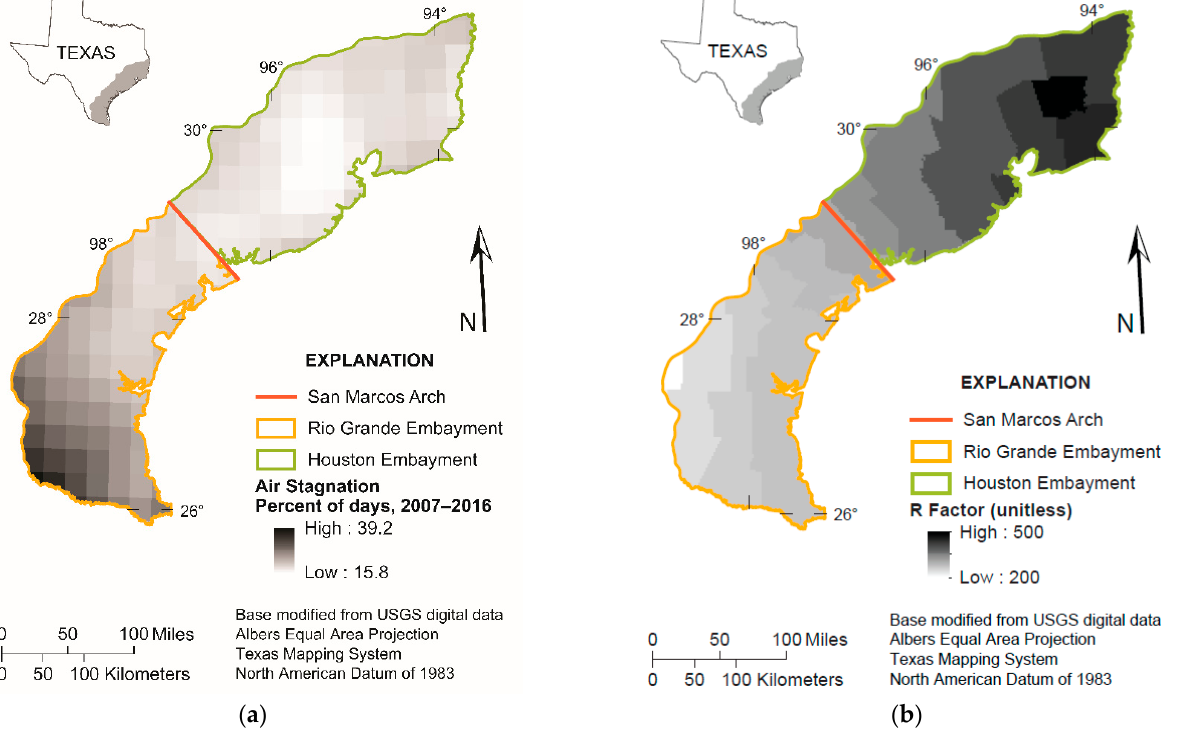
Figure 6. ( a ) The 10-year air stagnation index showing the percentage of days meeting criteria for air stagnation from 2007 to 2016 [12,37] and ( b ) R factor [11].